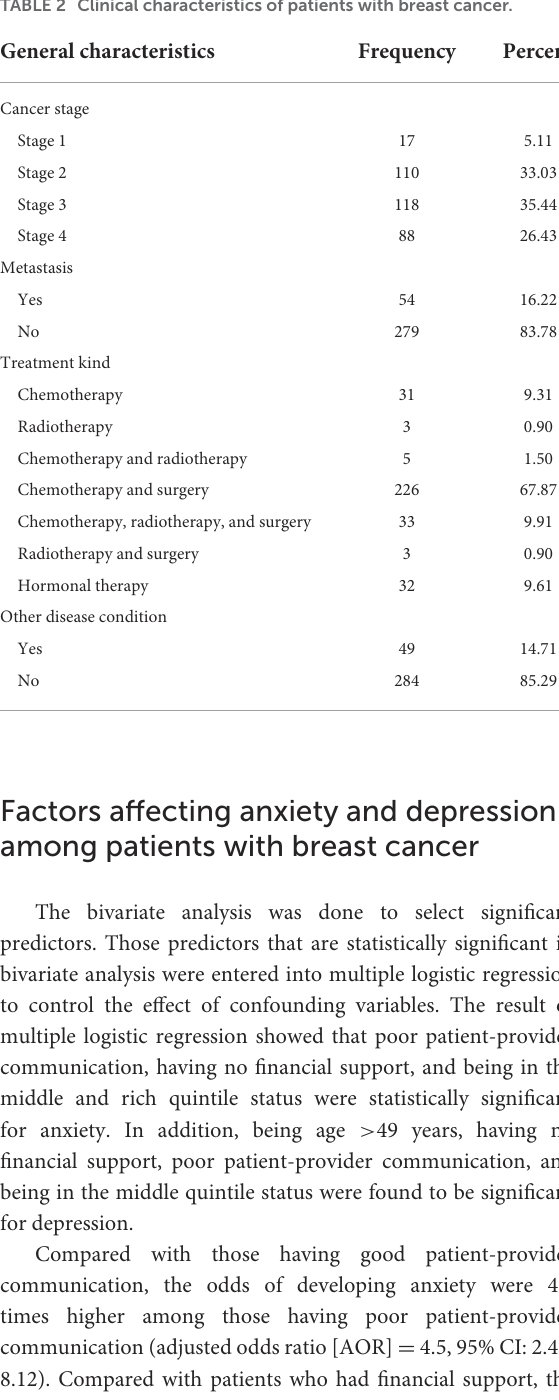
TABLE 2 Clinical characteristics of patients with breast